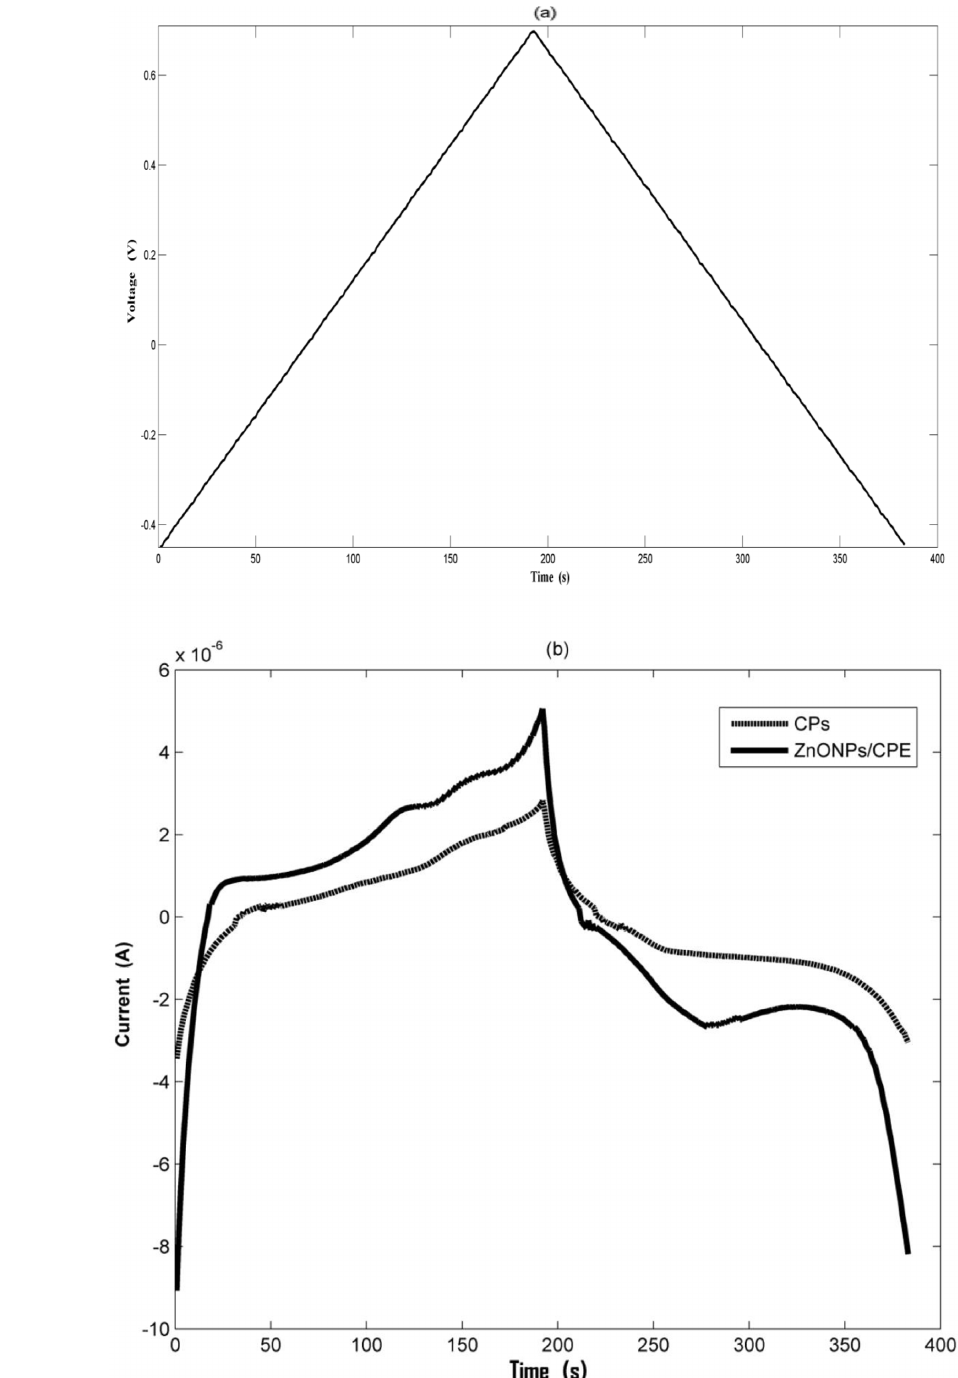
Figure 2. (a) The applied potential in the voltammogram; (b) the resultant current in the